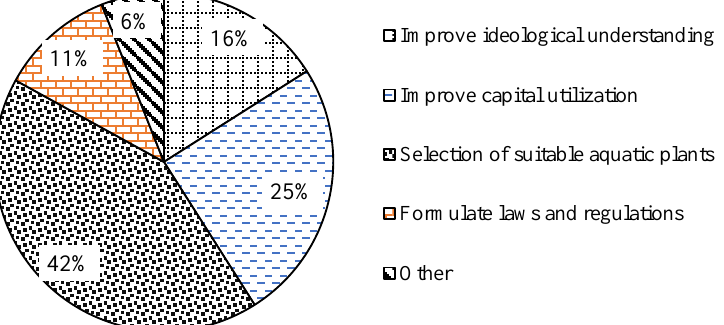
Figure 4. Ecological restoration measures of sponge city.